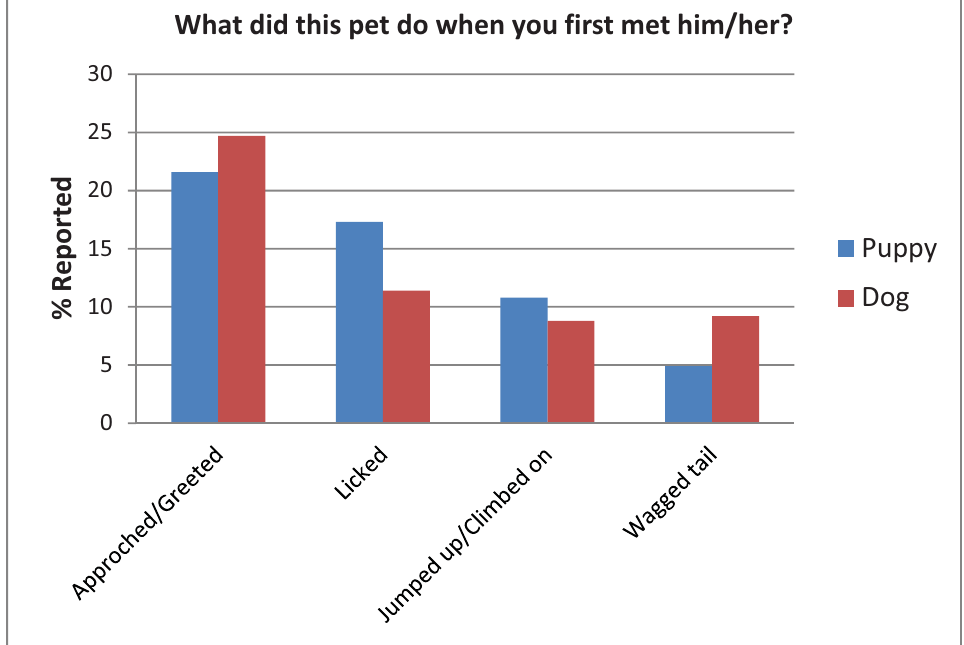
Figure 6. Adopter’s responses when asked the first behavior their puppy or dog exhibited upon meeting